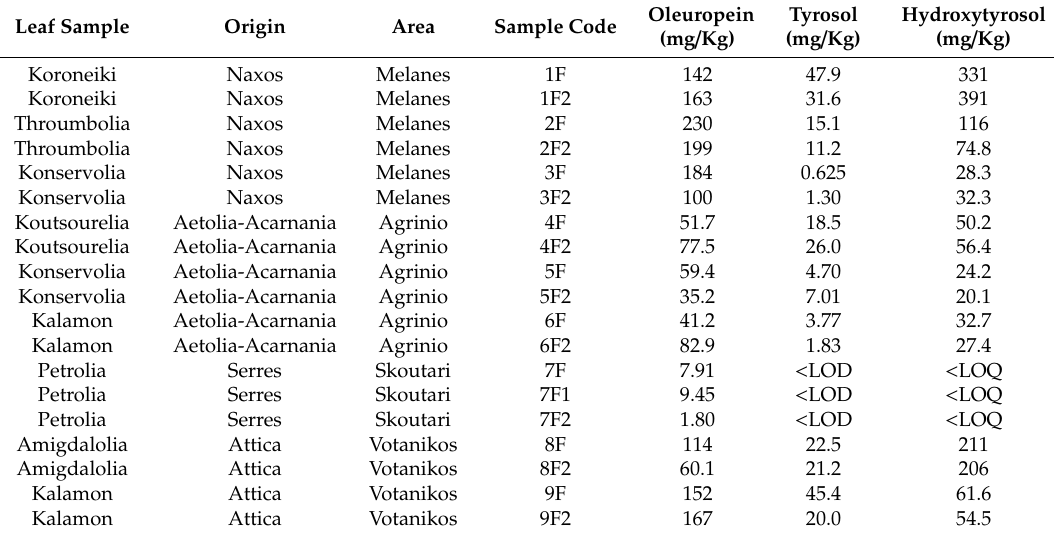
Table 4. Quantification results of oleuropein, tyrosol and hydroxytyrosol in